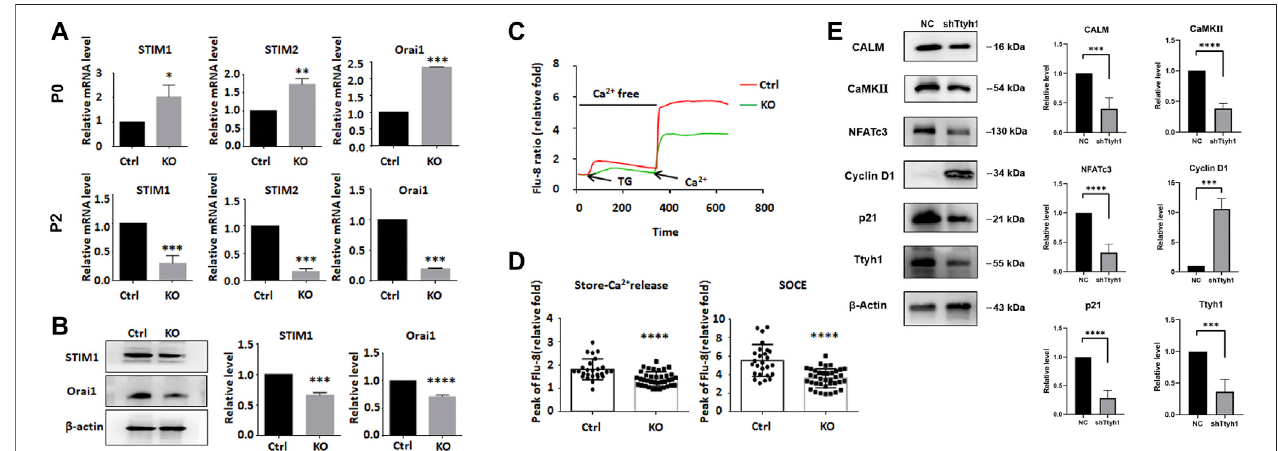
FIGURE 7 | Ttyh1 is involved in the regulation of calcium signaling in NSCs. (A) RT-qPCR analysis showed the expression levels of SOCE regulatory molecules between control and Ttyh1 KO neurospheres at primary culture (P0) and Passage 2 (P2). The RNA expressions of STIM1, STIM2, and Orai1 increased at P0, and decreased at P2 generation. (B) Western blotting analysis showed the protein levels of STIM1 and Orai1 between control and Ttyh1 KO neurospheres in P2 generation. (C,D) Intracellularcalcium measurementbetween controland Ttyh1 KO NSCs. Weused Flu8 tolabel the calcium ionsin NSCs, then add 10 μ MThapsigargin (TG) to induce store-Ca 2+ release from the endoplasmic reticulum, and fi nally add 2 μ M calcium chloride solution to detect the change of store-operated Ca 2+ entry (SOCE). Theresultsshowedthatbothstore-Ca 2+ releaseandSOCEreducedsigni fi cantlyinP2generationofTtyh1knockoutNSCs. (E) Westernblottinganalysisofdownstream molecules of Calcium signaling pathway. Representative Western blots (left) and quanti fi cation of bands intensities (right) are present. After Ttyh1 was knockdown by shRNA containing lentivirus, the protein levels of CALM, CaMKII, NFATc3, and p21 were decreased, and that of Cyclin D1 increased signi fi cantly. n ≥ 4 for all experiments. Data are expressed as mean ± SEM. Statistical signi fi cance was calculated using an unpaired, two-tailed Student ’ s t -test. ( p ) ( pppp ) p < 0.0001, ( ppp ) p < 0.001, ( pp ) p < 0.01, ( p ) p < 0.05.